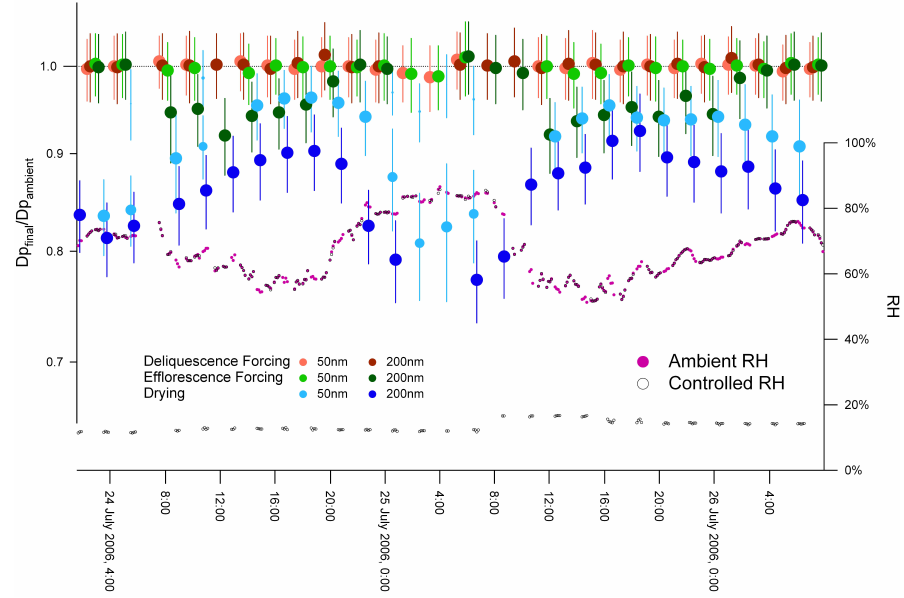
Fig. 8. A time series of AS-TDMA measurements from the summer campaign. The point and error bar markers follow the convention described in Sect. 2.3.